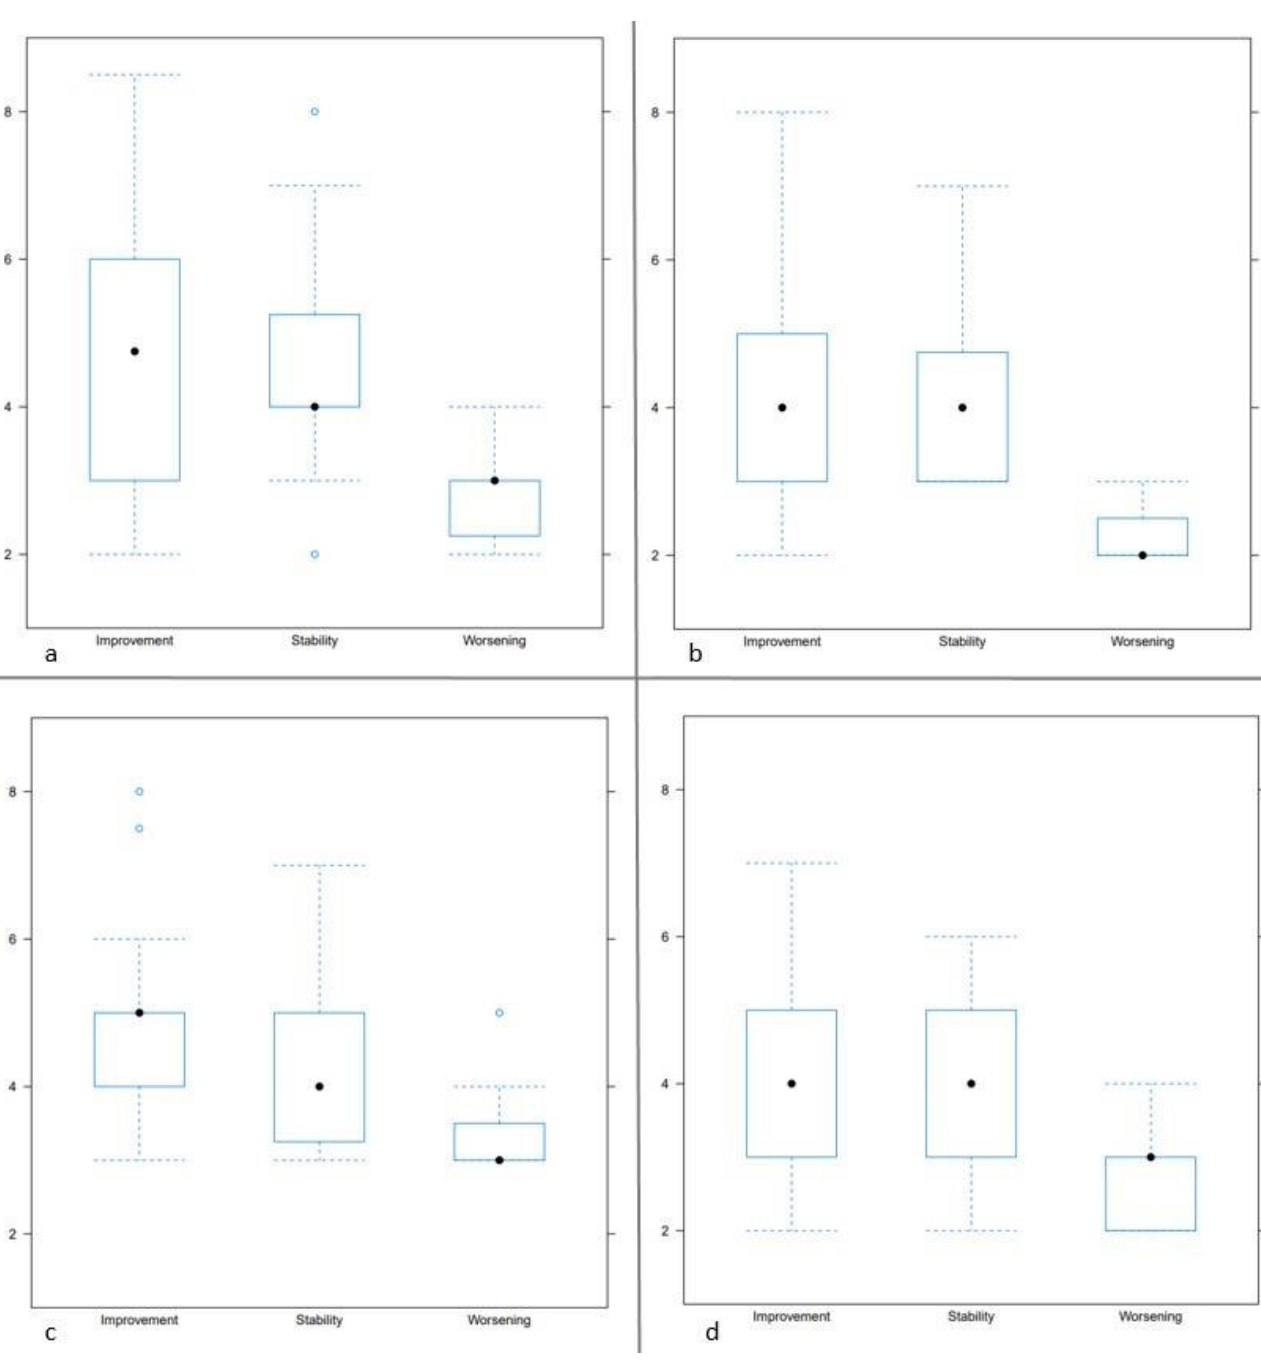
Figure 6. Box plot representing inferior glenohumeral ligament thickness ( y -axis) according to clinical outcomes for reader 1 on the glenoidal ( a ) and humeral side ( b ), and for reader 2 on the glenoidal ( c ) and humeral side ( d ).